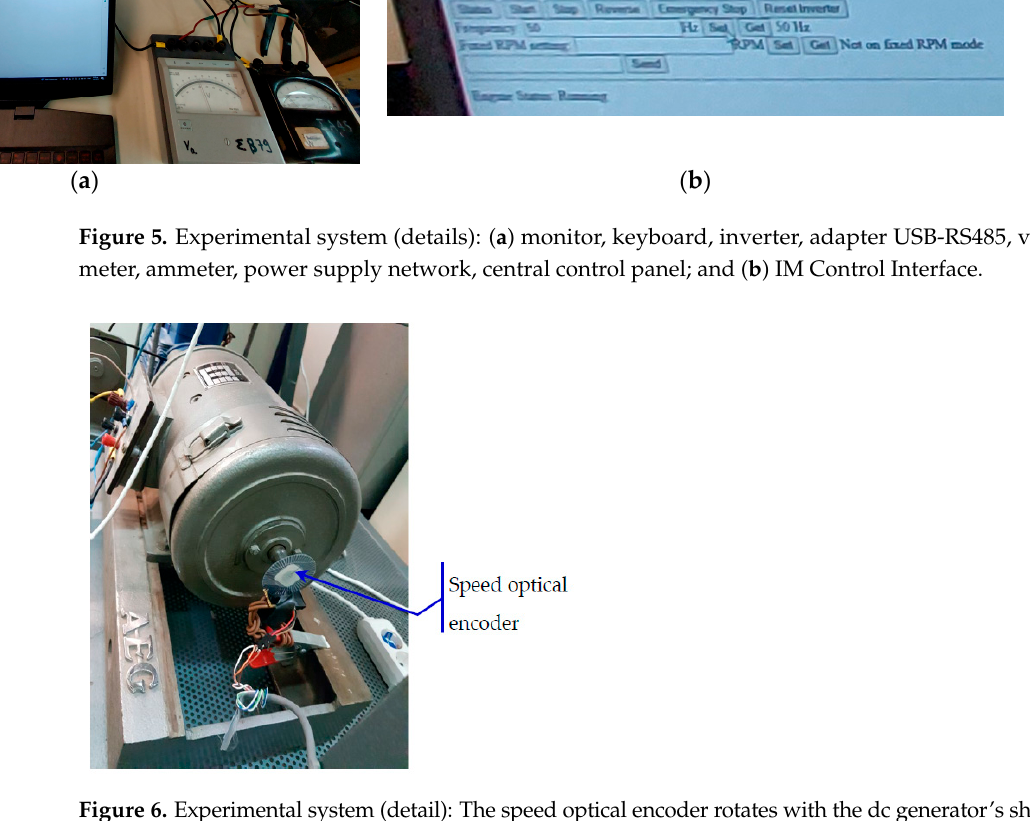
Figure 6. Experimental system (detail): The speed optical encoder rotates with the dc generator’s shaft.